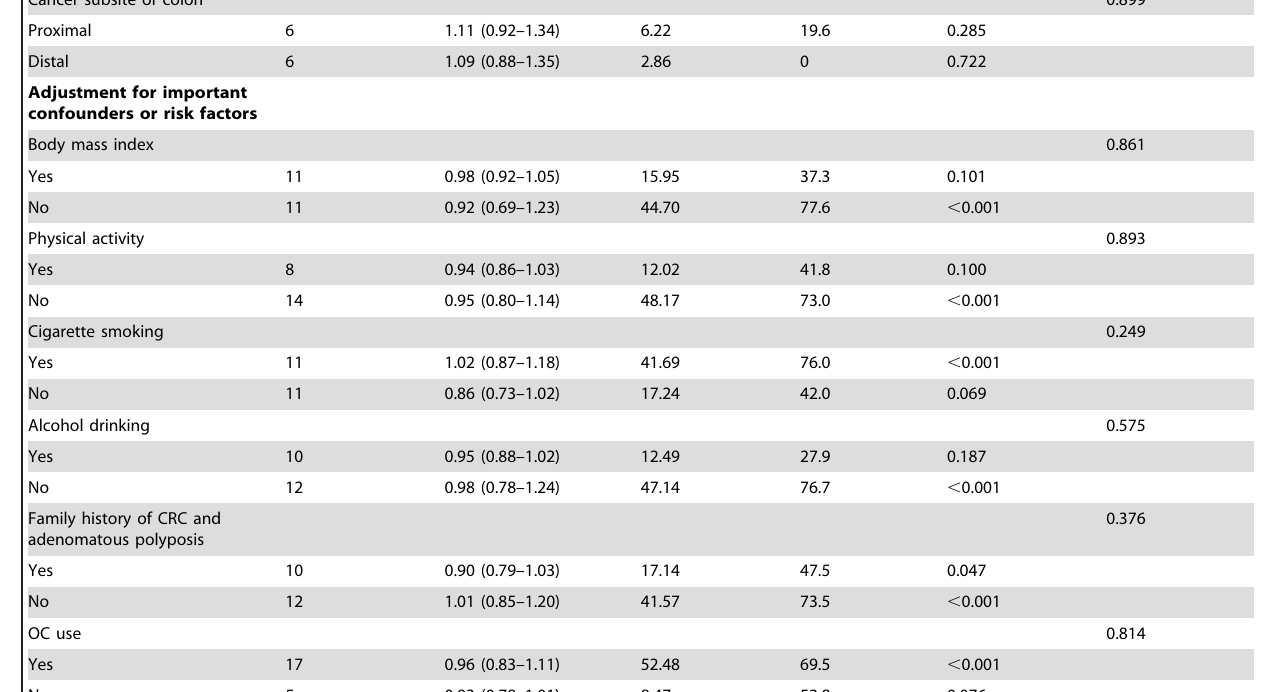
** P value for heterogeneity between subgroups with meta-regression analysis.